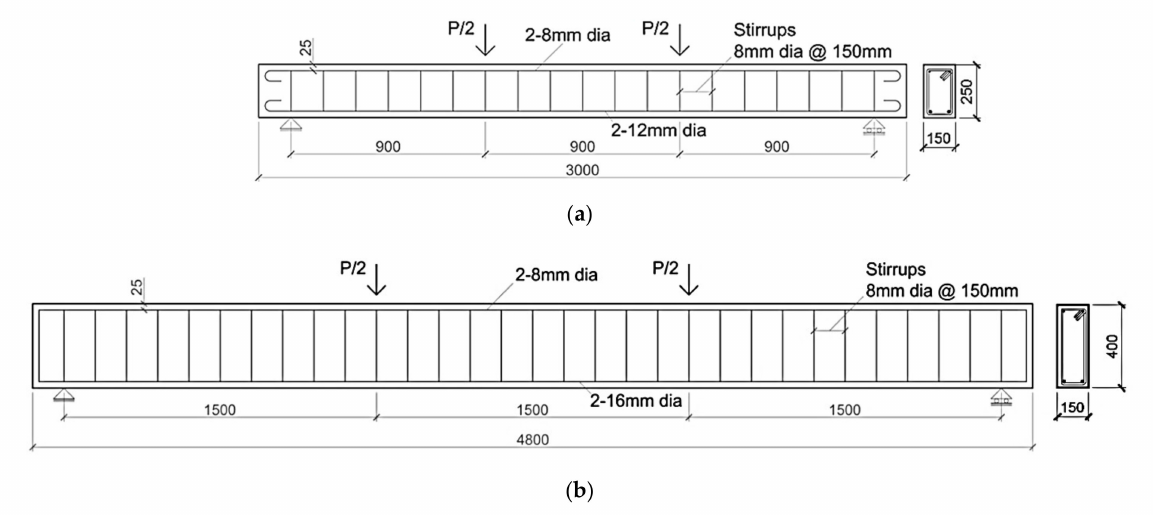
Figure 8. Geometrical details of the RC beams: ( a ) Group A; ( b ) Group